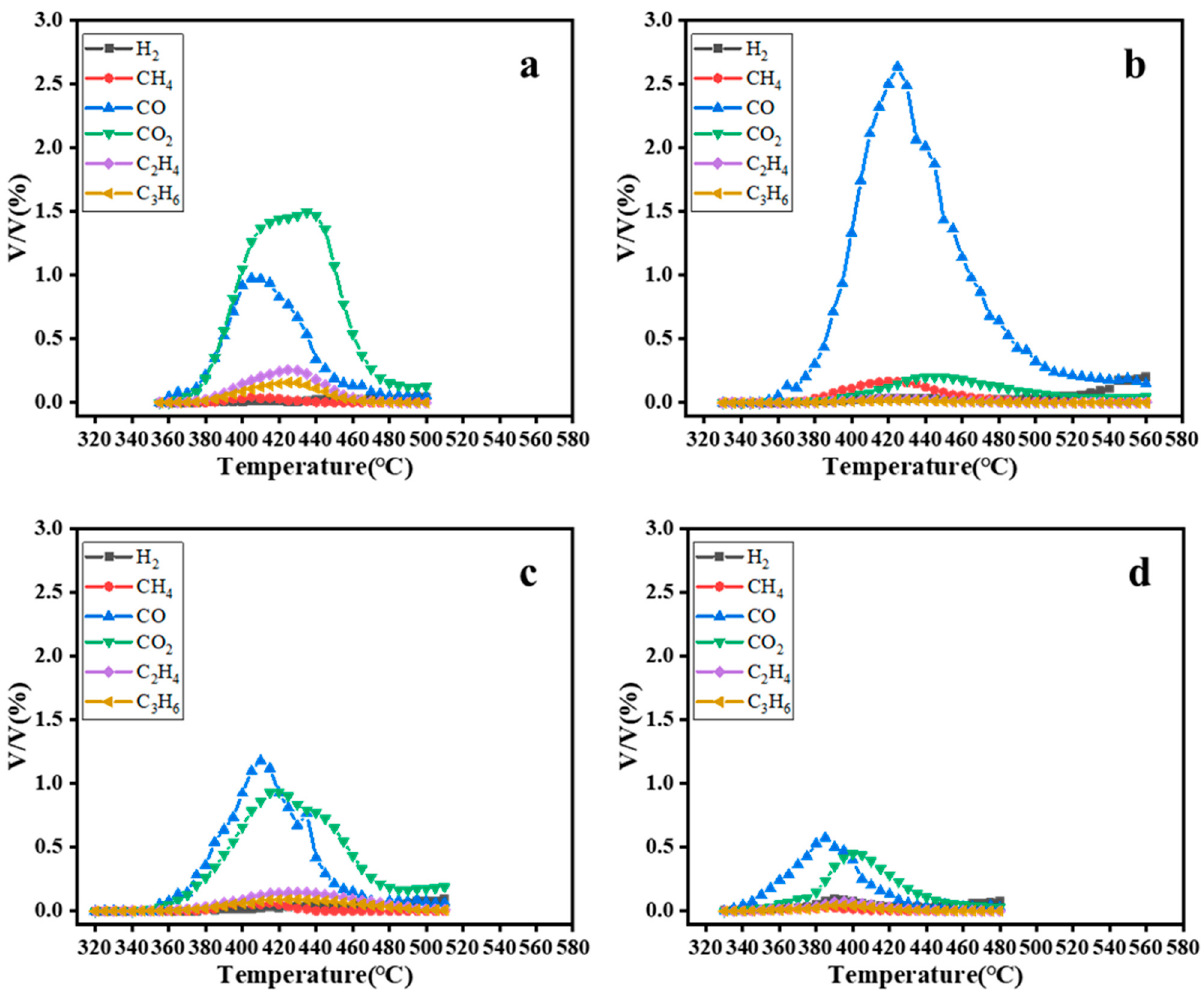
Figure 7. In situ GC analysis of the gas phase product components: ( a ) catalyst-free steam-assisted pyrolysis; ( b ) catalytic conventional pyrolysis (catalyst—Pt@Hzsm-5); ( c ) catalytic steam-assisted pyrolysis (catalyst—Hzsm-5); ( d ) catalytic steam-assisted pyrolysis (catalyst—Pt@Hzsm-5).